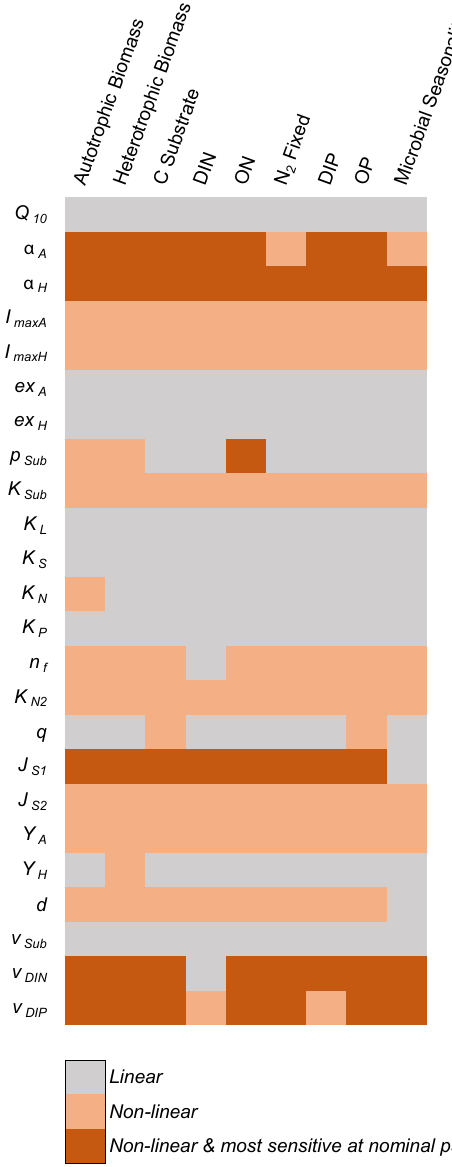
Figure 9. Heat map showing parameter linearity and non-linearity over a range of model outputs. The model is forced with meteoro- logical data from the Damma Glacier (Fig. 4) over 75